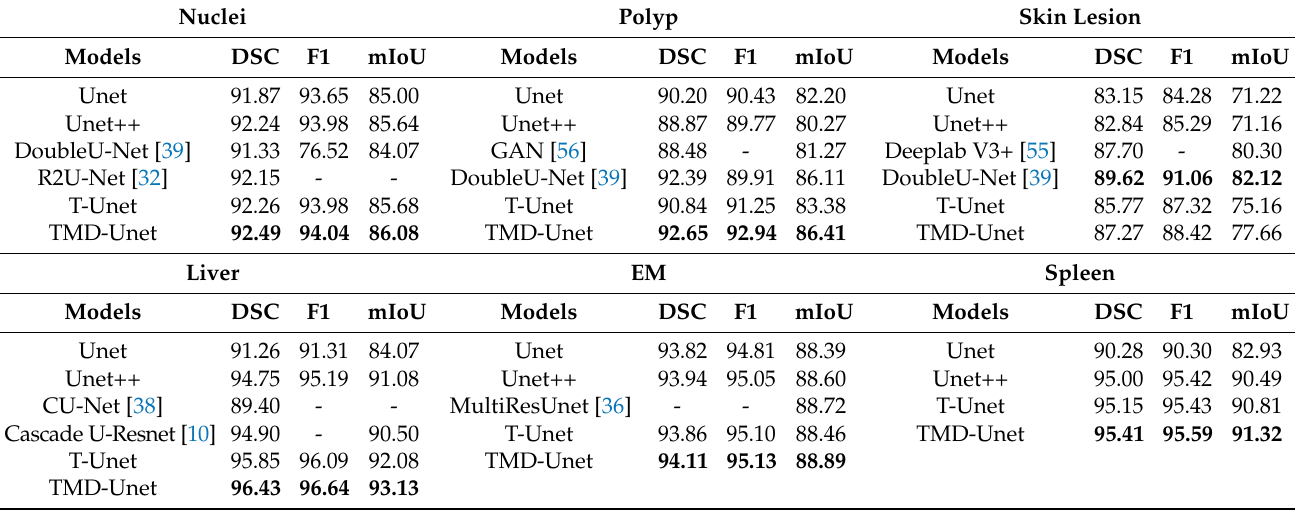
Table 5. Comparison of the proposed models with popular models. The bold data denotes the best value. Nuclei